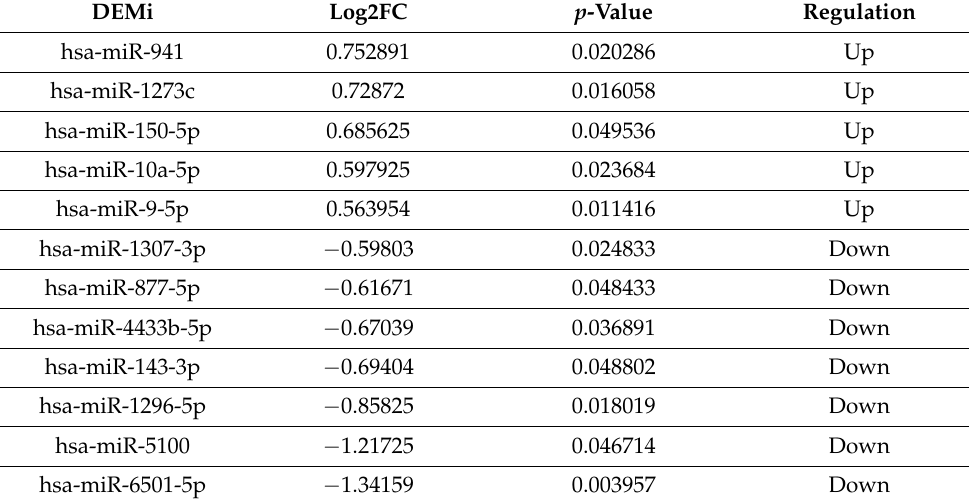
Table 1. DEMi candidates selected using edgeR. DEMi Log2FC p -Value